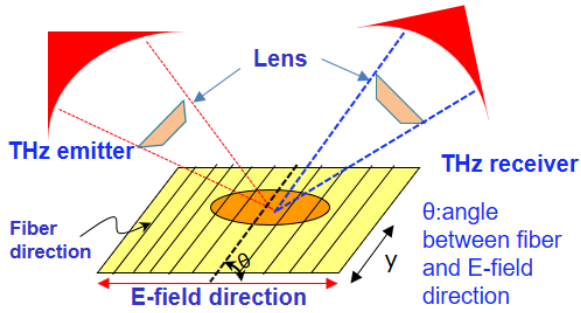
Figure 3. A simplified overview of the terahertz (THz) measurement method.